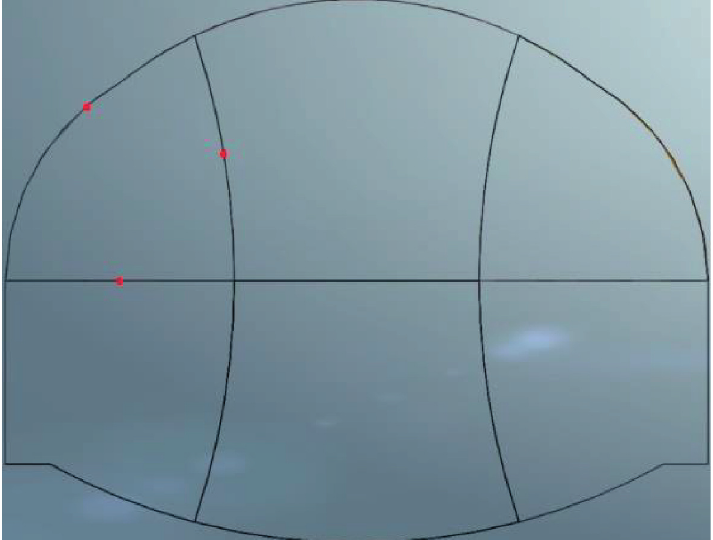
Figure 9: The stress value monitoring point layout of supporting